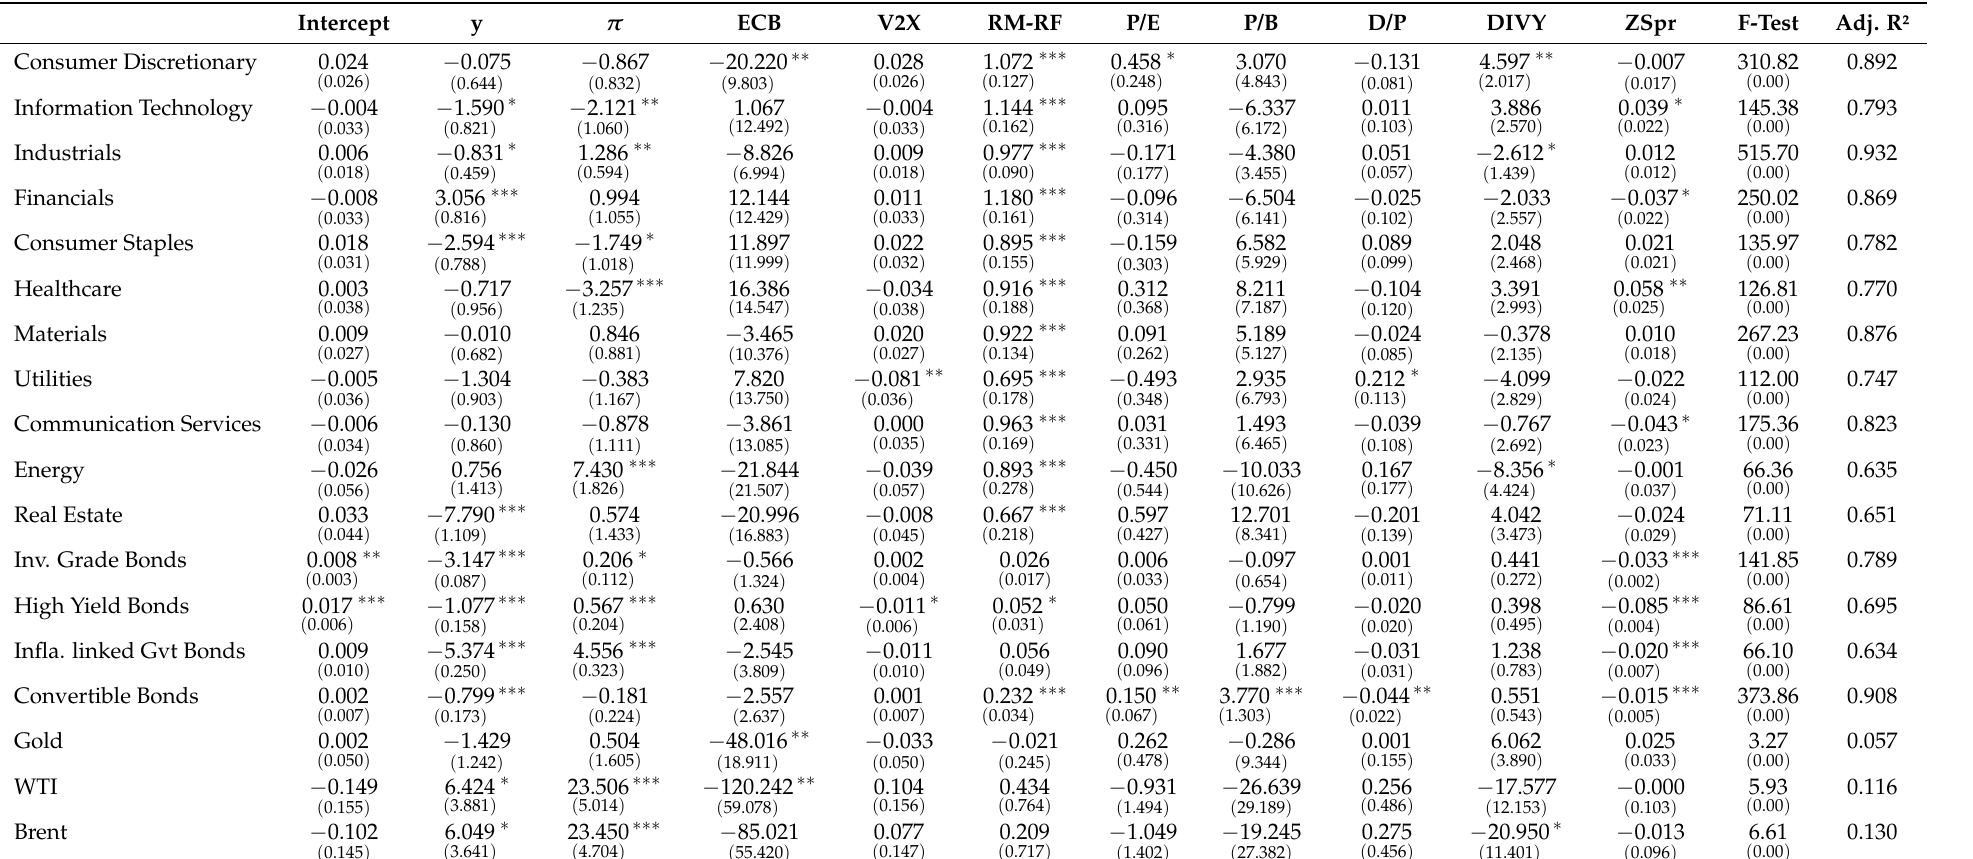
Table A2. Results of regressions conducted for our cross-asset panel for the high volatility regime of inflation expectations from 7 October 2014 to 7 December 2016. Error estimates are indicated in parentheses except for the F-Test, for which the p -value is in